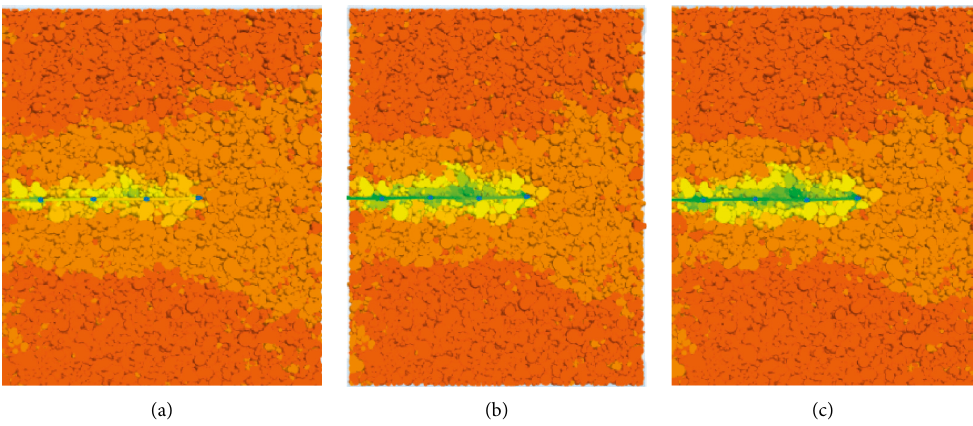
Figure 8: Evolution of the influencing zone under a vertical load of 100kPa. (a) 5mm, (b) 10mm, and (c) 15